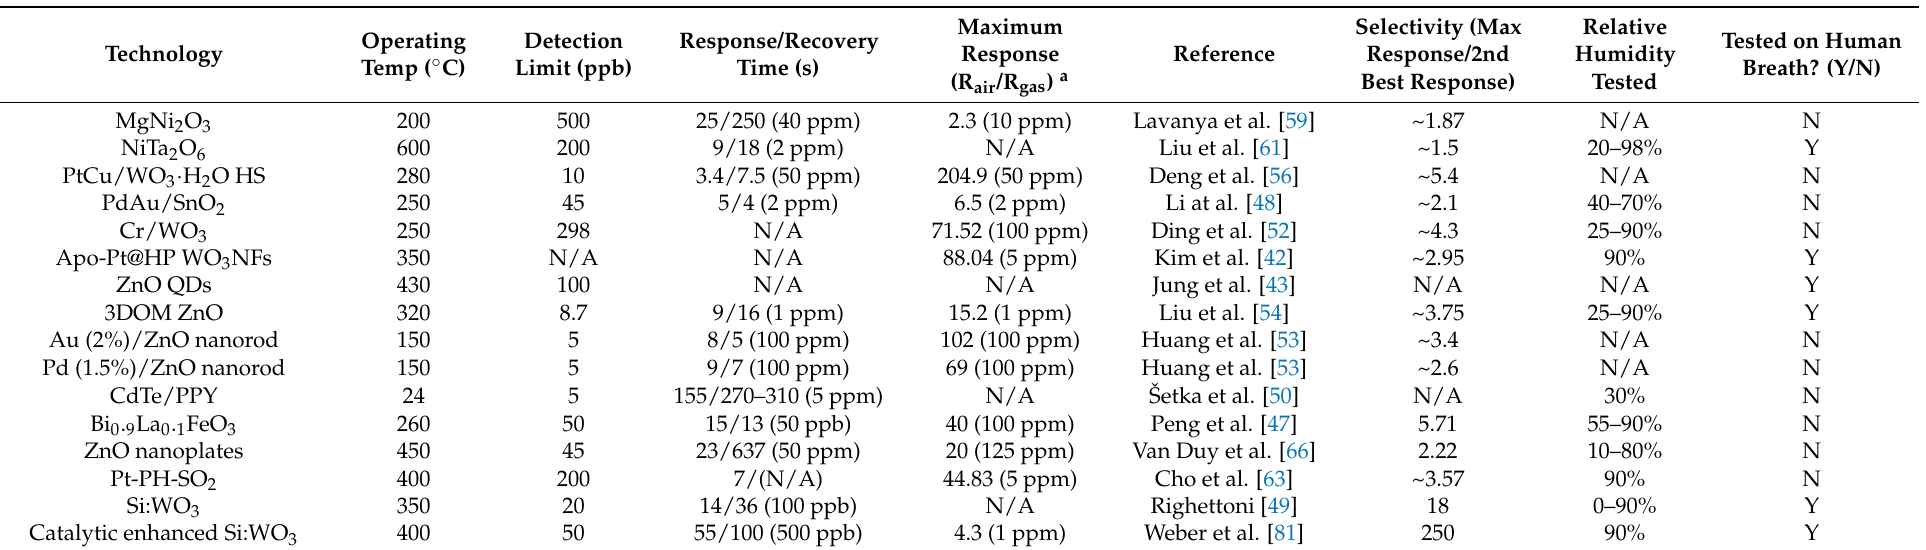
Table 2. All discussed semiconductor metal oxide (SMOs) and organic based